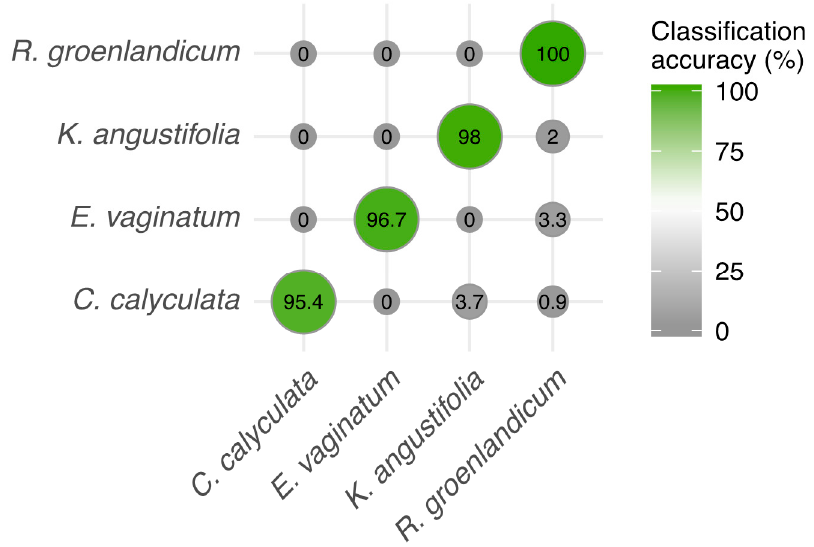
Figure 7. Classification accuracy per species using PLSDA on normalized leaf spectra based on 50 iterations, for which 70% of data were randomly selected to train the model and 30% were used to test the model. Number of PLSDA components: 4.